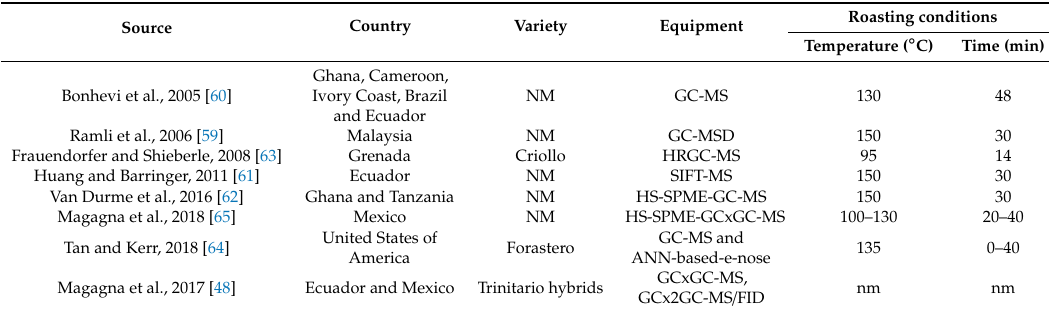
Table 4. Overview of the volatile organic compounds of roasted cocoa beans from di ff erent origins under di ff erent roasting